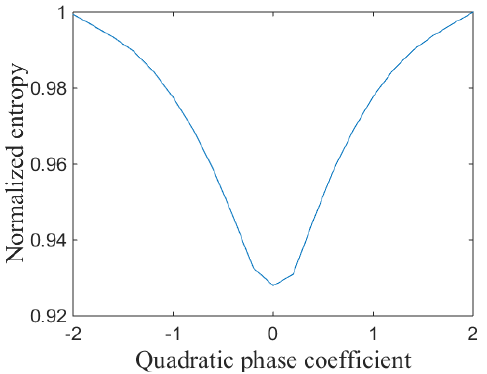
Figure 2. Relationship between normalized entropy and quadratic phase coefficient.